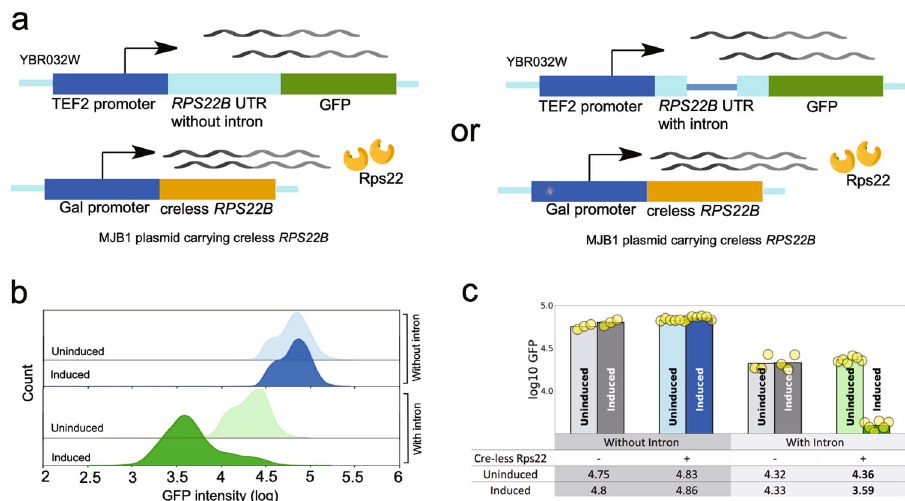
Fig. 3 RPS22B autoregulation. a Two reporter constructs were made to test the sequence requirements for autoregulation by overexpressed cre-less Rps22. One construct had the wild-type RPS22B 5 ’ UTR (containing a 557 bp intron) placed upstream of GFP and driven by the TEF2 promoter. A second construct was identical except that the intron was removed. Both constructs were separately integrated into the YBR032W locus and transformed with the plasmid for expressing cre-less Rps22. b Histograms of log10 GFP intensity from fl ow cytometry of cells containing either the UTR-with-intron reporter (green) or the UTR-without-intron reporter (blue). Cells were measured as either uninduced (lighter-shaded colors) or after induction of cre-less Rps22 (darker-shaded colors). Each histogram curve represents cells picked from a single colony after transformation of the cre-less plasmid. c Bar plot comparing the log GFP levels of the two reporter constructs in cells with or without the plasmid for expression of cre-less Rps22 and with or without galactose induction. Circles represent the measurements of individual transformants and the bar is the mean, also listed in the table